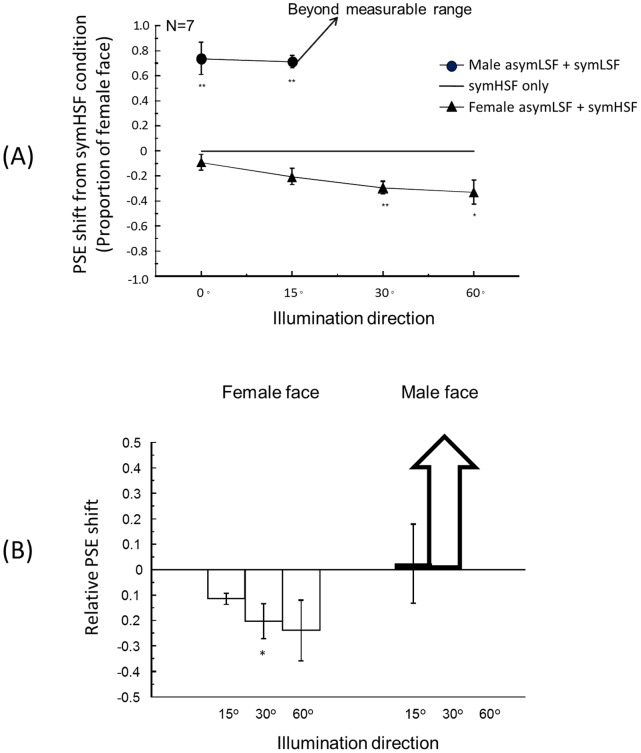
PSE shift.(A) AsymLSF effect on PSE shift from the symHSF only condition averaged across observers. (B) Relative PSE shift from the 0° lighting direction. The error bars represent one standard error. The statistically significant difference at p<.05, and 0.01 in a two-tailed paired t-test after Bonferroni correction are indicated by one, and two asterisks respectively. The averaged PSE shifts at male face 30° and 60° illumination directions were so great that they were beyond the measurable range, as indicated by the arrows.